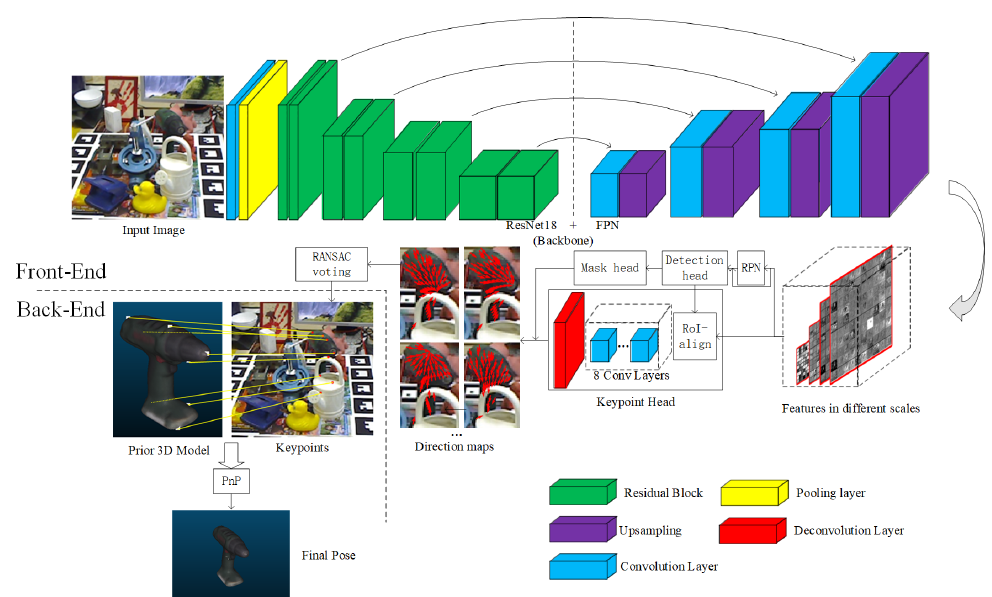
Figure 1. The structure of the network for keypoint